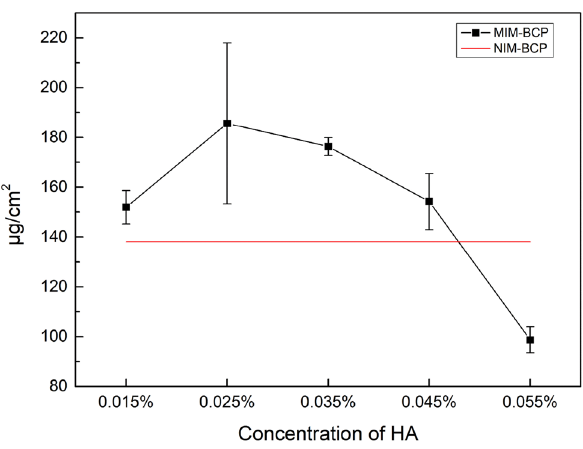
Figure 11: The dynamic adsorption of HA on the MIM - BCP and NIM - BCP.